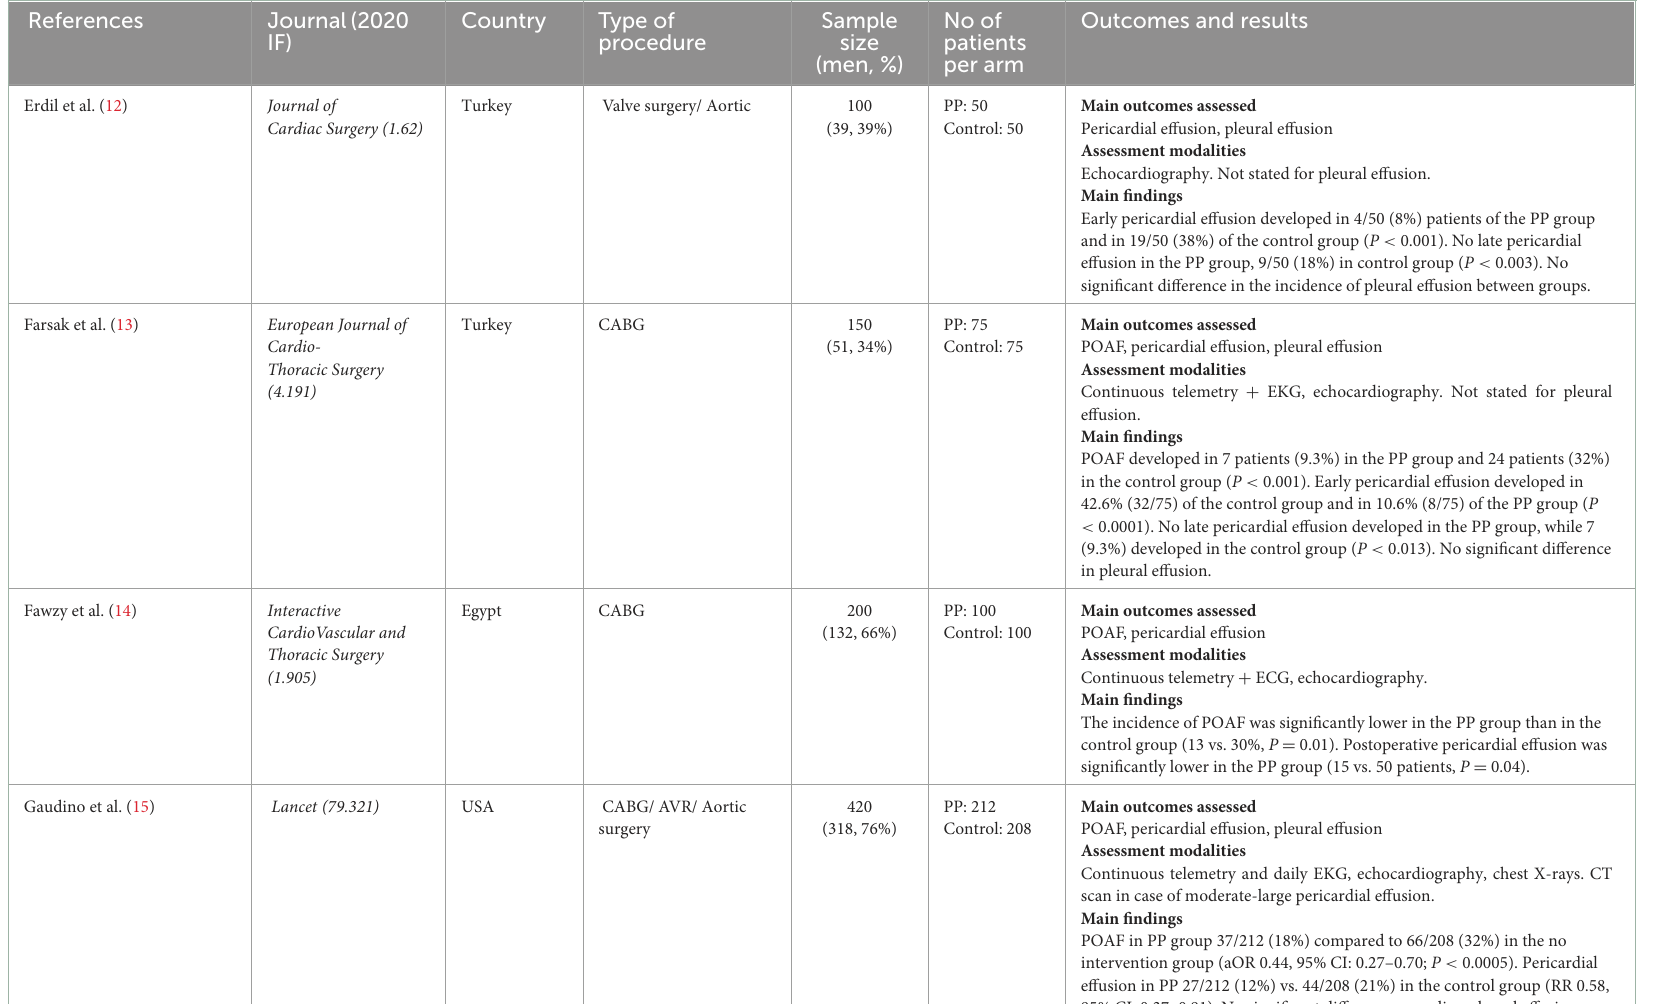
Main outcomes assessed Pericardial effusion, pleural effusion Assessmentmodalities Echocardiography. Not stated for pleural effusion. Main findings Early pericardial effusion developed in 4/50 (8%) patients of the PP group and in 19/50 (38%) of the control group ( P < 0.001). No late pericardial effusion in the PP group, 9/50 (18%) in control group ( P < 0.003). No significant difference in the incidence of pleural effusion between groups. Main outcomes assessed POAF, pericardial effusion, pleural effusion Assessmentmodalities Continuous telemetry + EKG, echocardiography. Not stated for pleural effusion. Main findings POAF developed in 7 patients (9.3%) in the PP group and 24 patients (32%) in the control group ( P < 0.001). Early pericardial effusion developed in 42.6% (32/75) of the control group and in 10.6% (8/75) of the PP group ( P < 0.0001). No late pericardial effusion developed in the PP group, while 7 (9.3%) developed in the control group ( P < 0.013). No significant difference in pleural effusion. Main outcomes assessed POAF, pericardial effusion Assessmentmodalities Continuous telemetry + ECG, echocardiography. Main findings The incidence of POAF was significantly lower in the PP group than in the control group (13 vs. 30%, P = 0.01). Postoperative pericardial effusion was significantly lower in the PP group (15 vs. 50 patients, P = 0.04). Main outcomes assessed POAF, pericardial effusion, pleural effusion Assessmentmodalities Continuous telemetry and daily EKG, echocardiography, chest X-rays. CT scan in case of moderate-large pericardial effusion. Main findings POAF in PP group 37/212 (18%) compared to 66/208 (32%) in the no intervention group (aOR 0.44, 95% CI: 0.27–0.70; P < 0.0005). Pericardial effusion in PP 27/212 (12%) vs. 44/208 (21%) in the control group (RR 0.58, 95% CI: 0.37–0.91). No significant difference regarding pleural